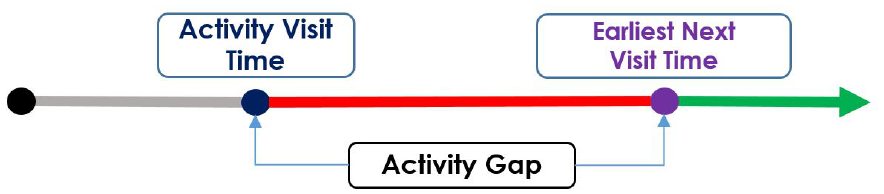
Figure 4. Activity gap represents the time between the two visits (the red axis), and the agent can return and do the activity only after this gap time is passed (the green